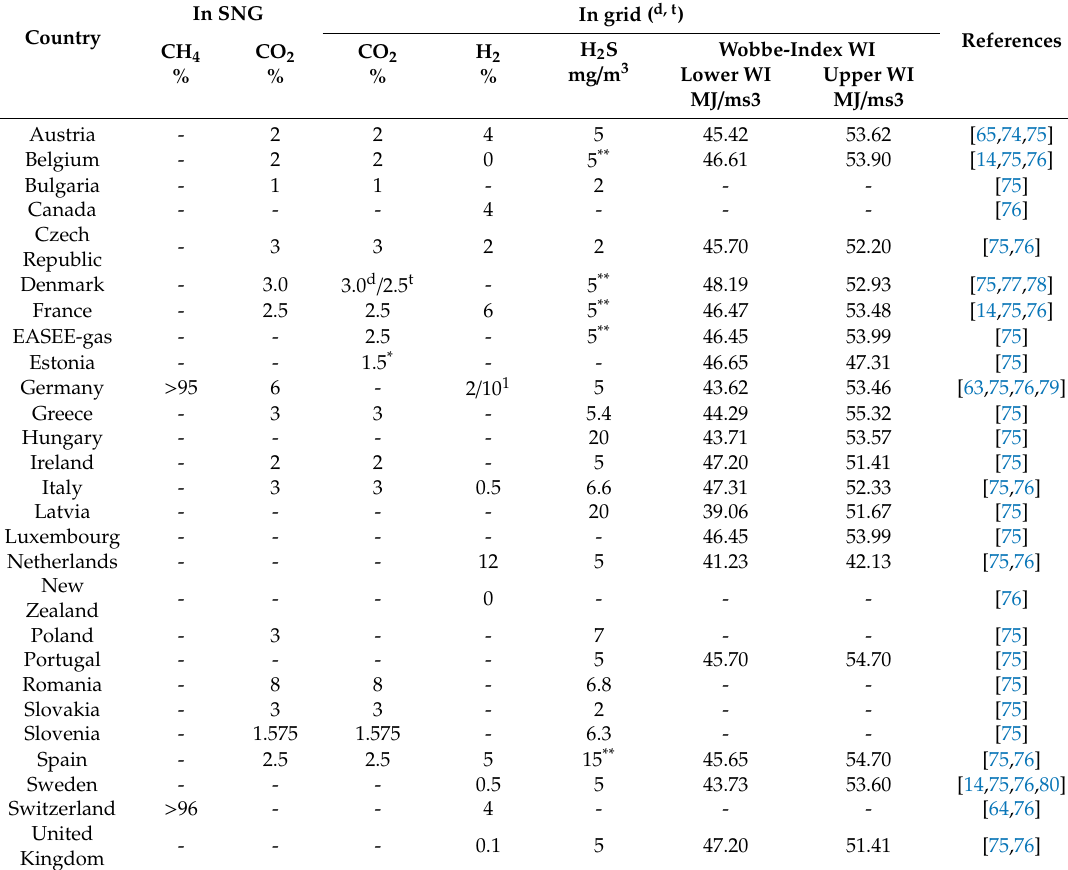
Table 4. Regulative standards and regulations on natural gas quality and SNG in di ff erent countries with a focus on